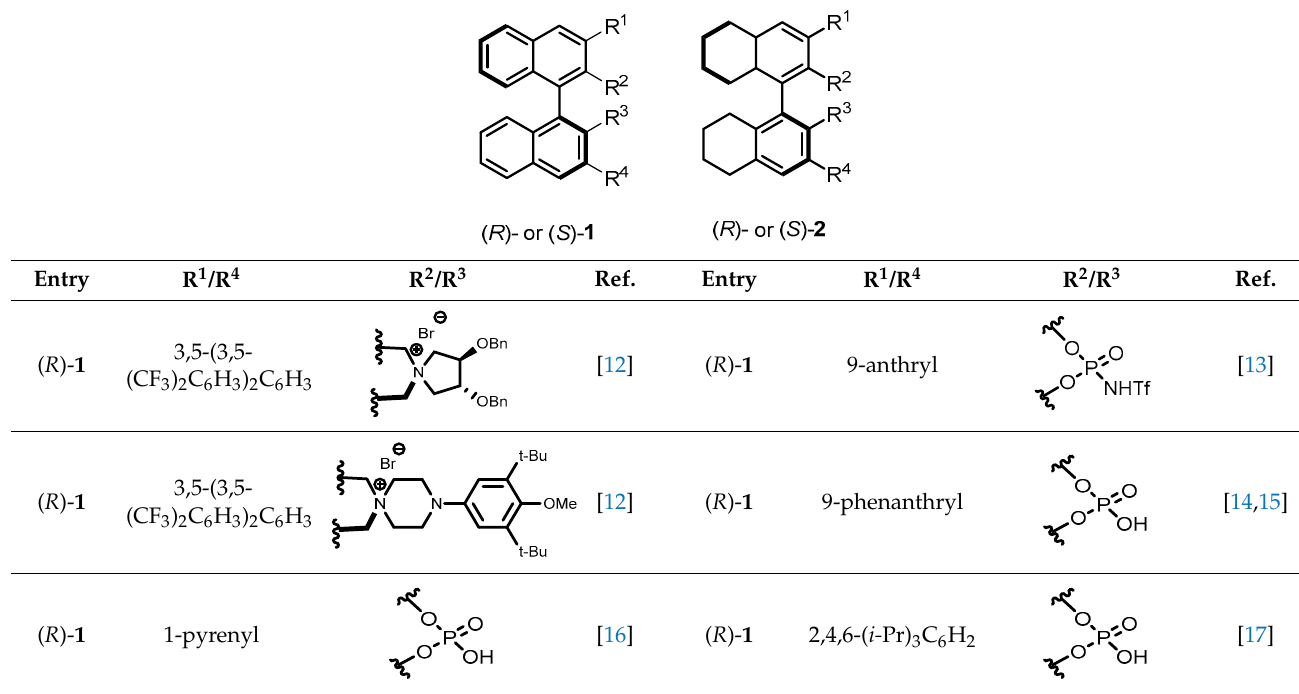
Figure 2. Examples of biologically active compounds with axial chirality.